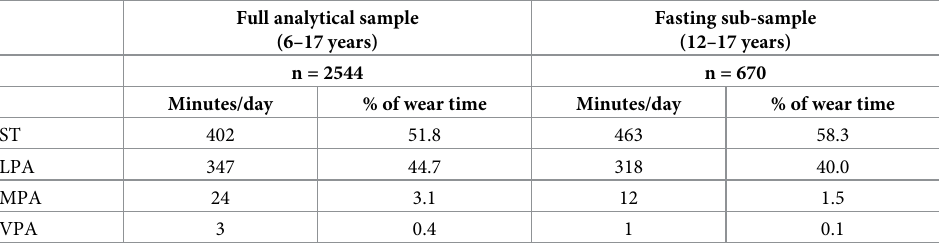
Table 2. Geometric means for ST and PA in minutes/day and corresponding percentage of wear time.